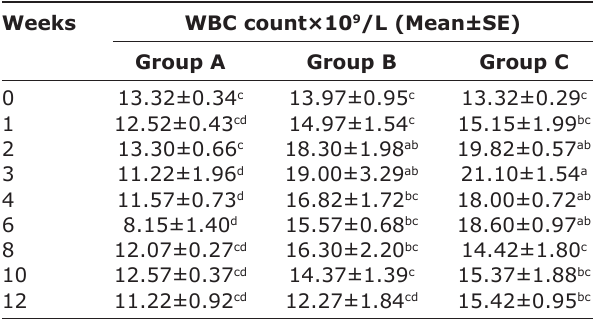
abc Values in different superscripts within row are significantly different at p<0.05. Group A: Buffered peptone saline, Group B: MA and Group C: C. pseudotuberculosis. C. pseudotuberculosis = Corynebacterium pseudotuberculosis , MA=Mycolic acid, SE=Standard error, MCHC=Mean corpuscular hemoglobin concentration Table-6: WBC count in female goat’s postinoculation with C. pseudotuberculosis and MA.